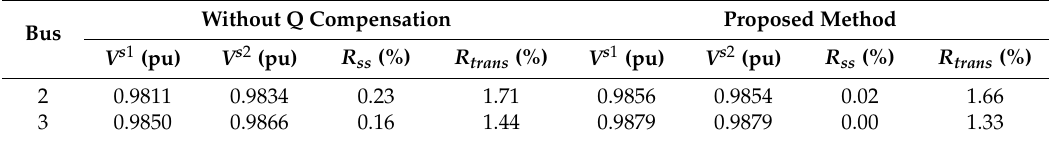
Figure 8. Voltage responses with the proposed method in Case 2. ( a ) Bus 2 ( b ) Bus 3. Table 6. Comparison of voltage variations in Case